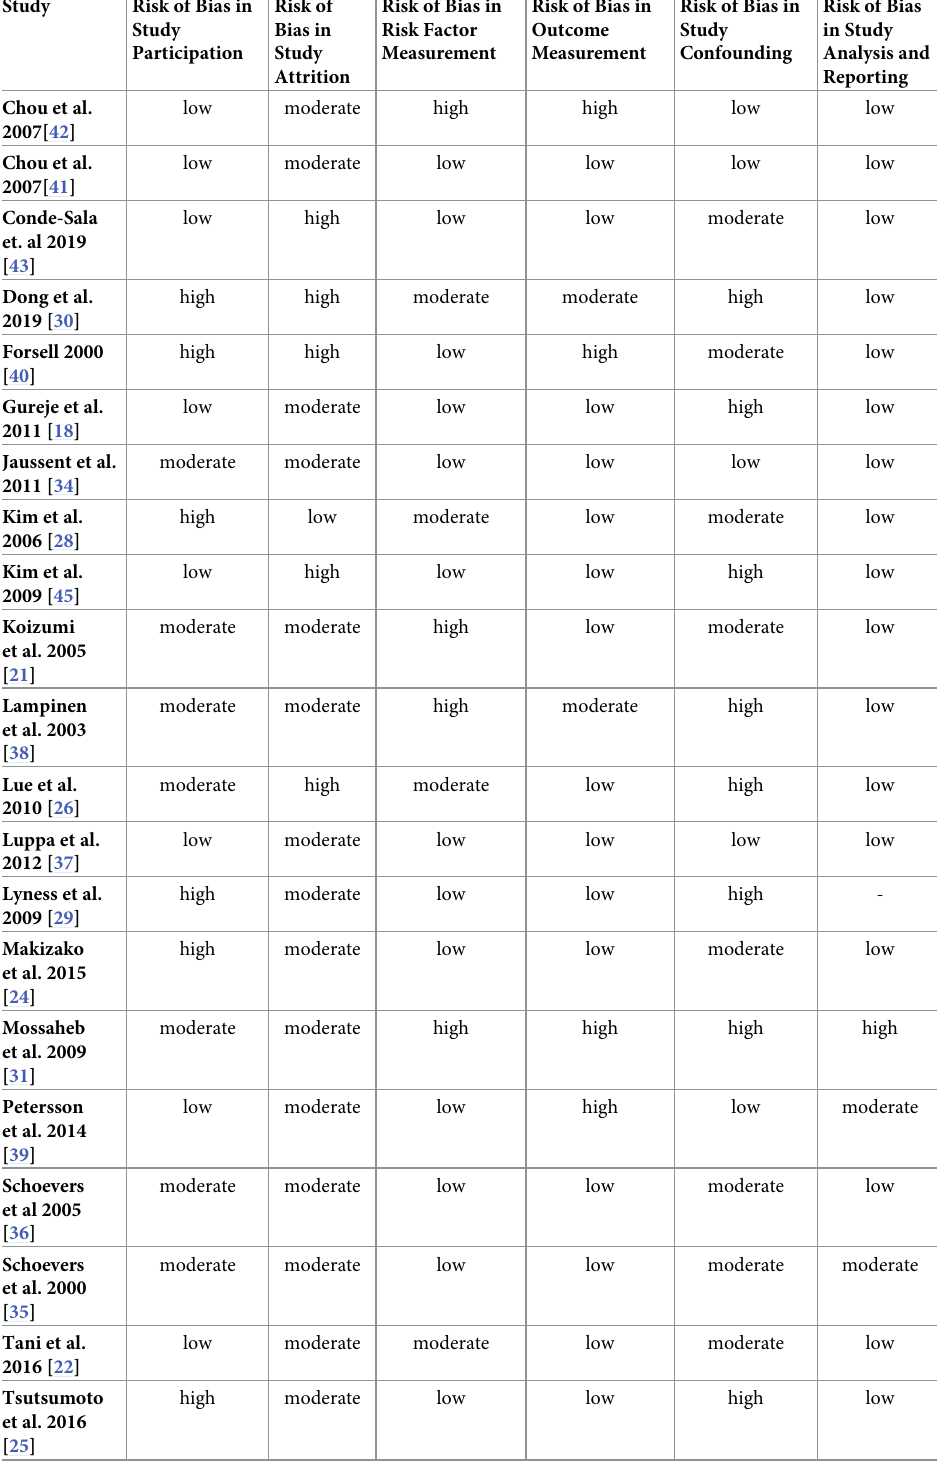
Table 5. Judgement of risk of bias in 6 domains applying QUIPS